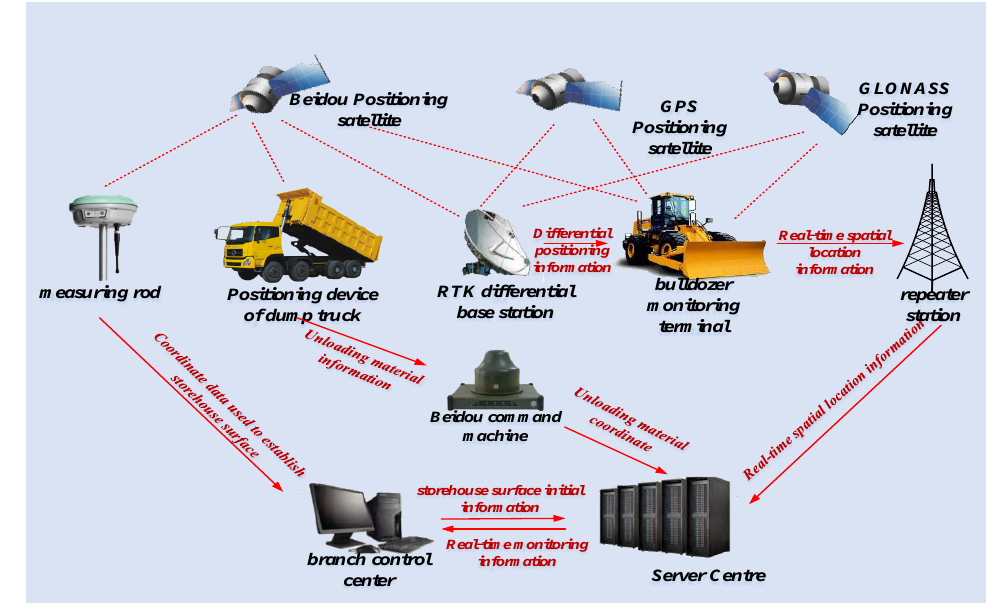
Figure 8. Real-time acquisition process of paving operation parameters.